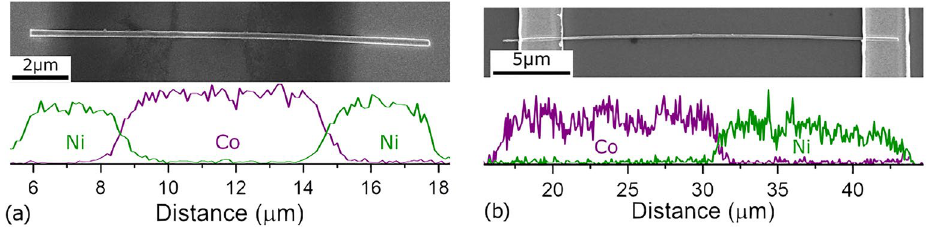
Figure 2. Scanning electron microscope image (top) and composition spectra (bottom) of ( a ) Ni/Co/Ni and ( b ) Co/Ni nanowires.